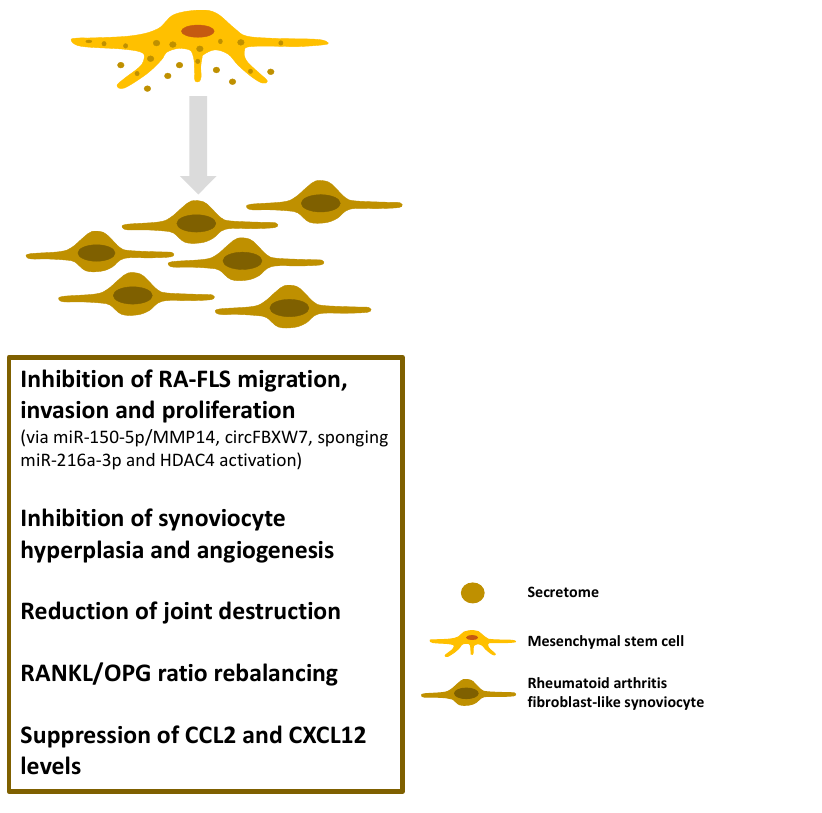
Figure 4. The anti-inflammatory and immunomodulatory effects of the MSC-secretome in rheumatoid arthritis. The figure depicts how components of the MSC-secretome contribute to the amelioration of disease activity. (RA-FLS: rheumatoid arthritis fibroblast-like synoviocyte; MMP: matrix metalloproteinase; HDAC4: histone deacetylase 4; RANKL: receptor activator of nuclear factor kappa-B ligand; OPG: osteoprotegerin; CCL2: C–C motif chemokine ligand 2; CXCL12: C-X-C motif chemokine ligand 12).